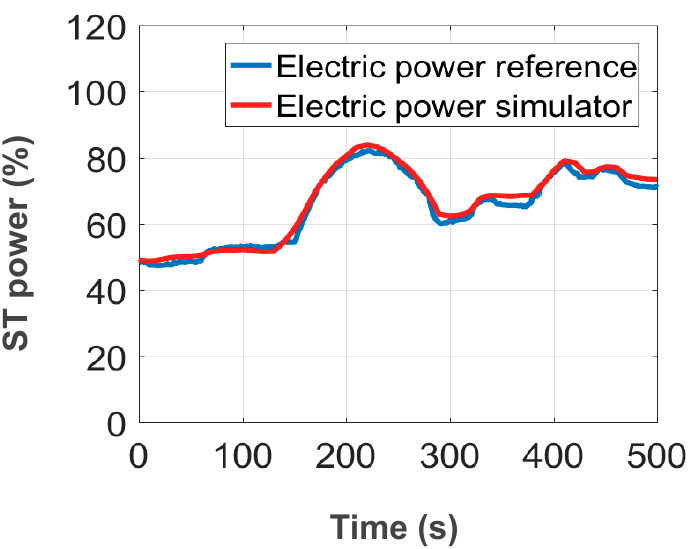
Figure 4. Steam Turbine (ST) modeling validation: comparison between reference data and simulation.